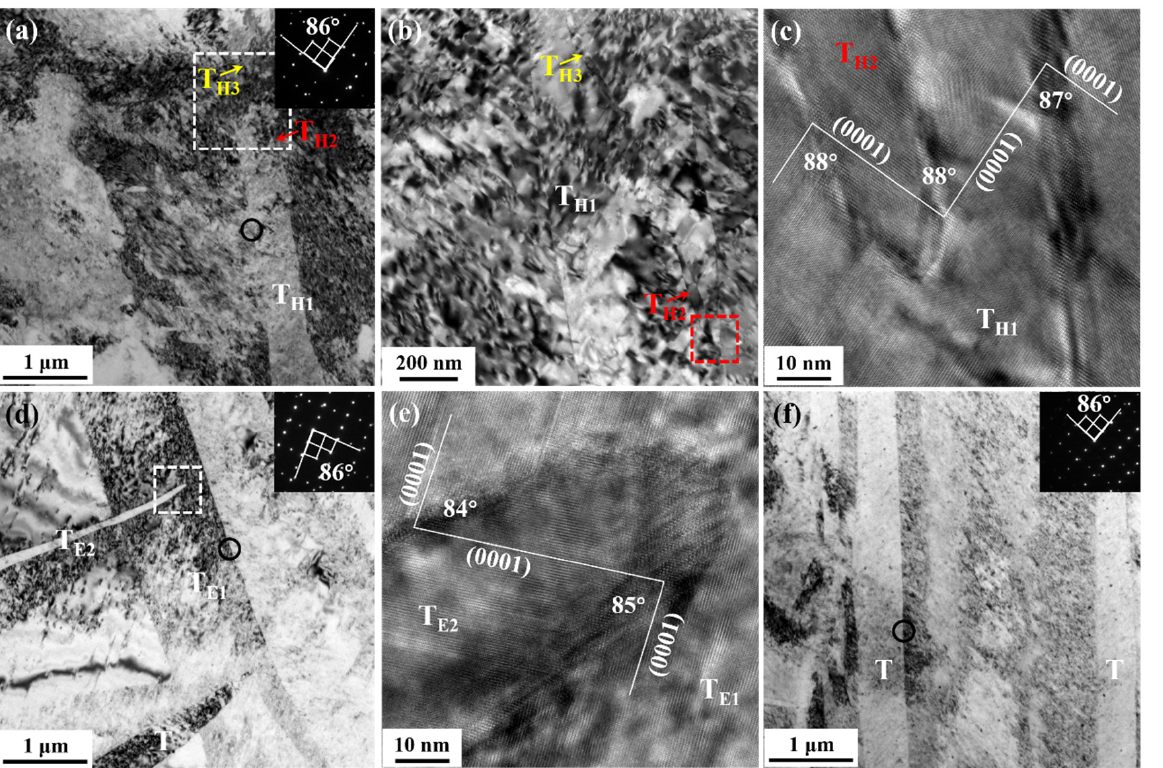
Figure 4. ( a ) Microstructure in the HS-1 sample; ( b ) magnification of the white dotted box in ( a ); ( c ) magnification of the red dotted box in ( b ); ( d ) microstructure in the E9S-1 sample; ( e ) magnification of the white dotted box in ( d ); ( f ) microstructure in the E25S-1 sample. Corresponding SAED patterns of the black circle areas are provided as insets in the micrographs.